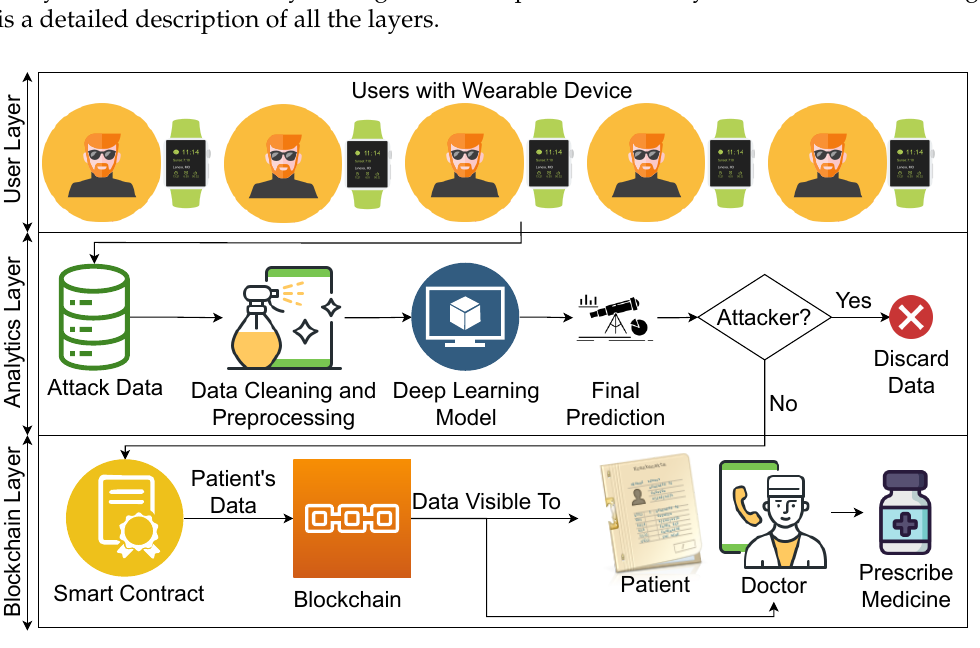
Figure 2. HEART system